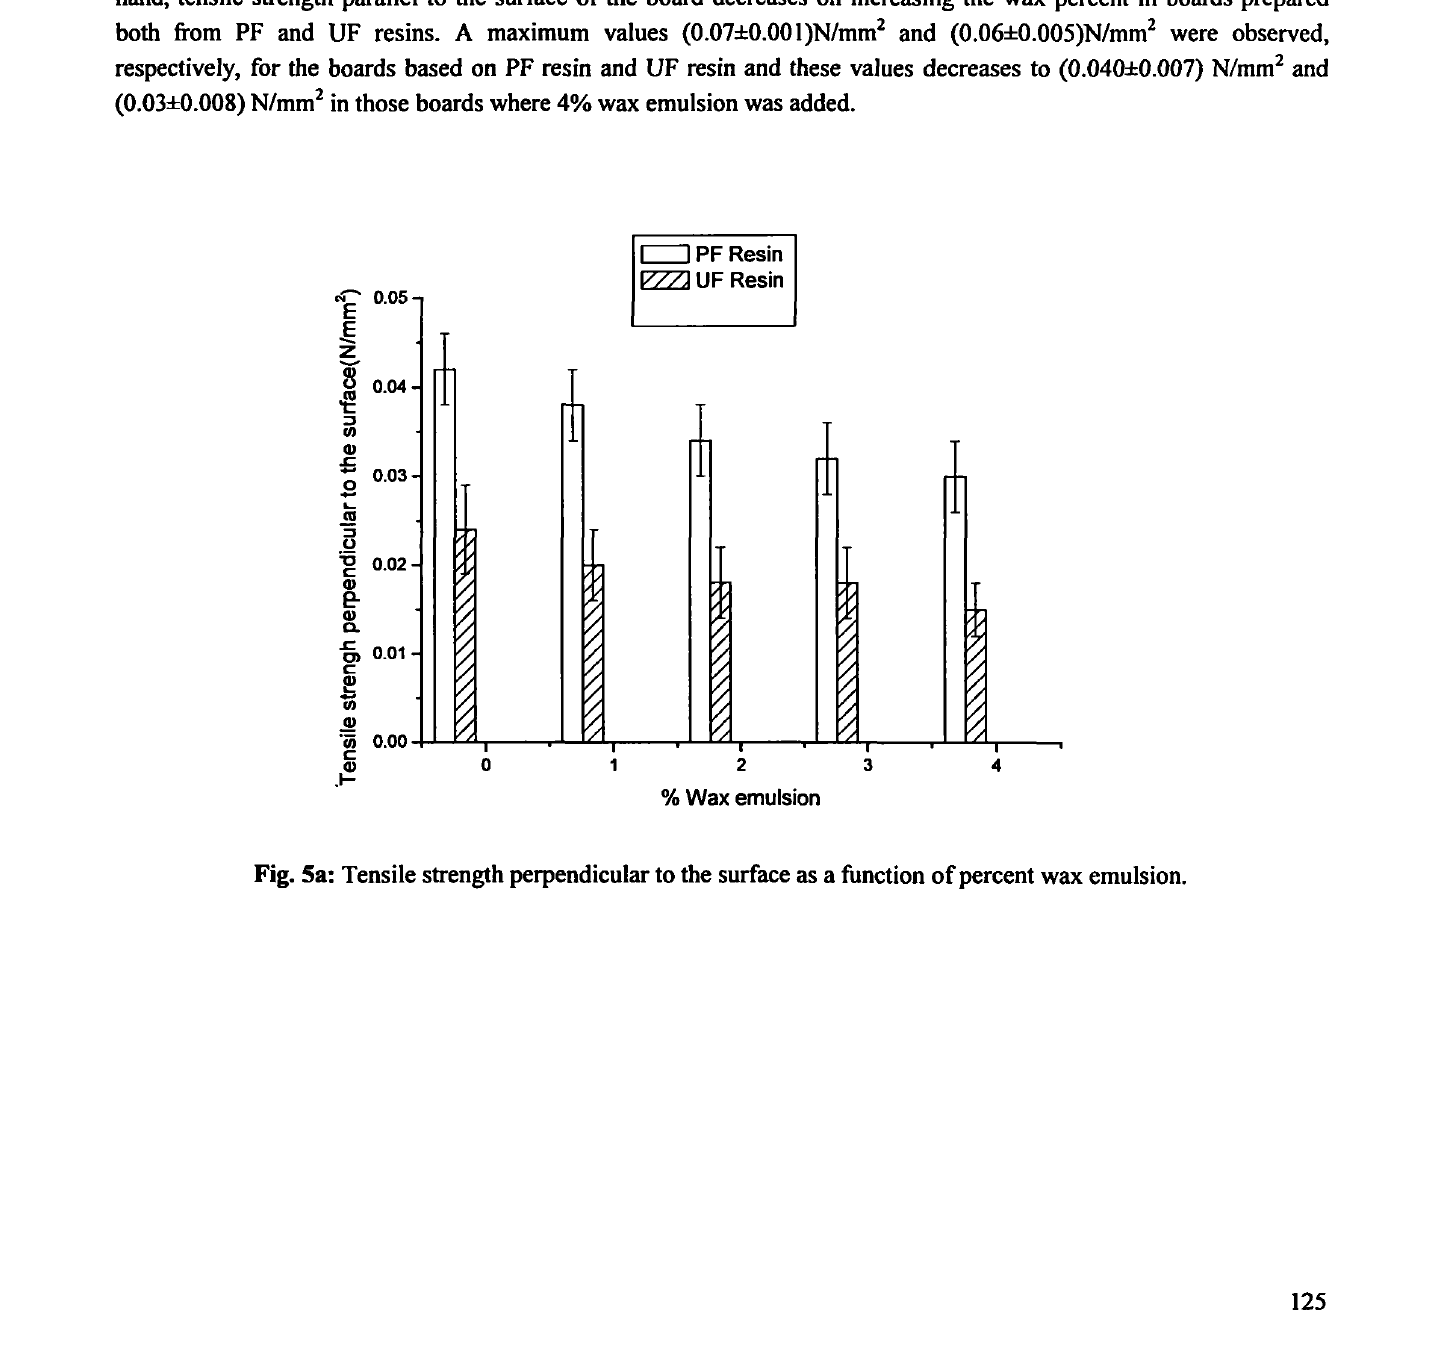
Fig. 5a: Tensile strength perpendicular to the surface as a function of percent wax